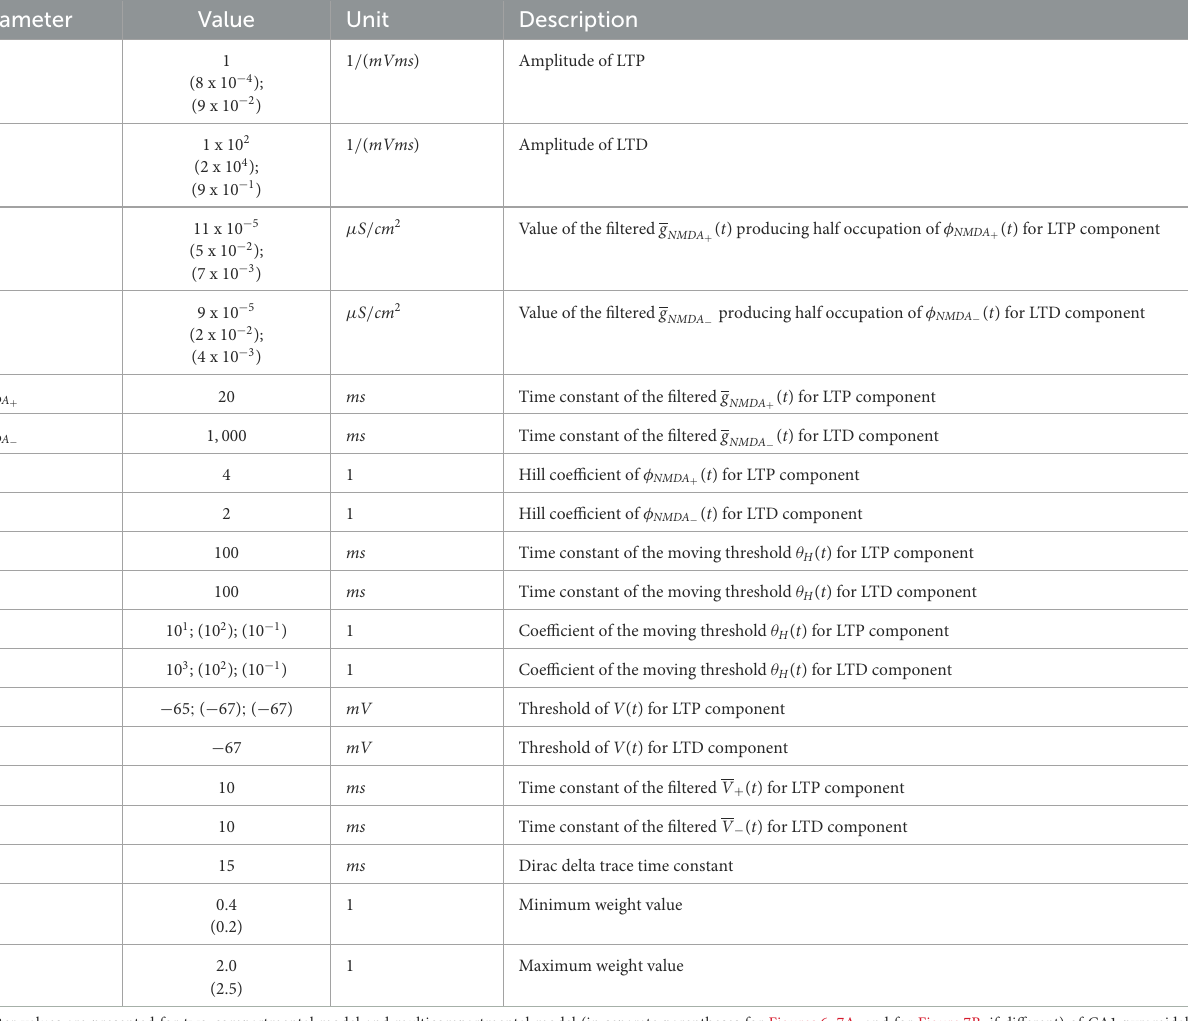
Parameter values are presented for two-compartmental model and multicompartmental model (in separate parentheses for Figures6, 7A, and for Figure7B, if different) of CA1 pyramidal neuron. TABLE 2 Parameters of NMDAR synapse.